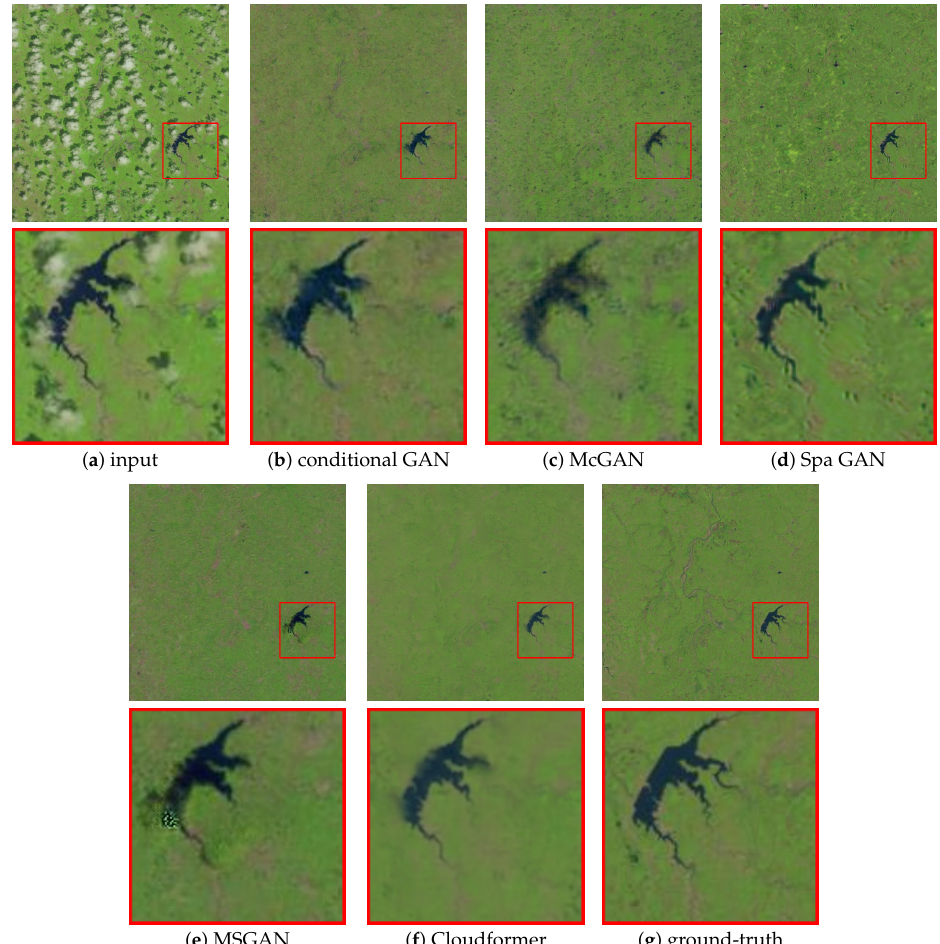
Figure 11. Comparative experimental results on the first sample of RICE2. When clouds in the image appear as small blocks, conditional GAN and MSGAN cannot remove cloud shadows well. Some white pixels also appear in the results of MSGAN, destroying the continuity of the image. The image recovered by McGAN is too blurry in the outline of the lake, while the result of Spa GAN has many erroneous textures. Our method successfully removes clouds and cloud shadows, outperforming other methods in terms of image texture and